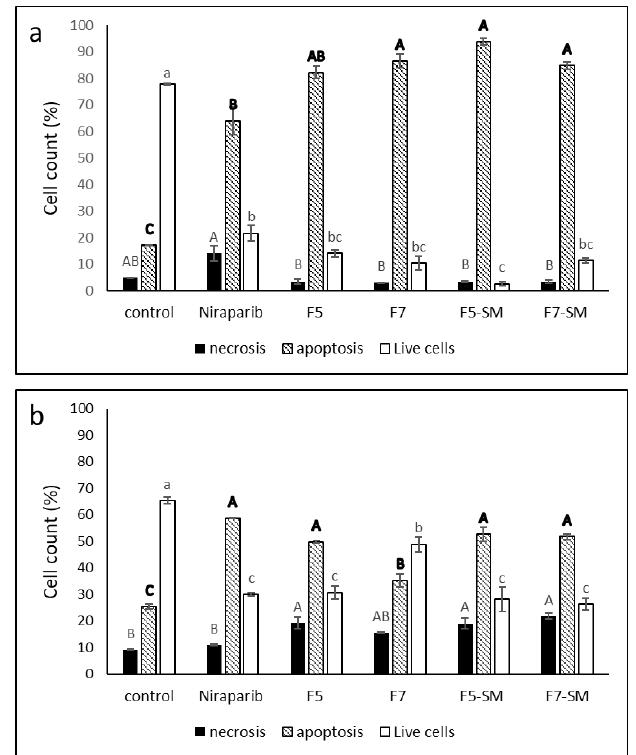
Figure 5. Percentage of viable, apoptotic, or necrotic, HTB75 cells ( a ) or HTB161 cells ( b ) following treatment with niraparib (5.1 µg/mL and 24.8 µg/mL respectively), F5 (19.1 µg/mL and 26.2 µg/mL respectively), F7 (19.4 µg/mL and 24.5 µg/mL respectively), F5-SM (17.4 µg/mL and 30.1 respectively), or F7-SM (16.3 µg/mL and 30.1 µg/mL respectively) for 48 h. 10 4 cells were analyzed per treatment. Control was vehicle control (1% methanol or 0.5% DMSO v/v for HTB75 and 3% methanol or 1.2% DMSO v/v for HTB161). The treated cells were harvested and analyzed by flow cytometry following annexin V-FITC/PI staining. Error bars indicate ± SE ( n = 3). Levels with different Upper or lower case letters of similar font and style were significantly different from all combinations of pairs according to the Tukey–Kramer honest significant difference (HSD; p ≤ 0.05).